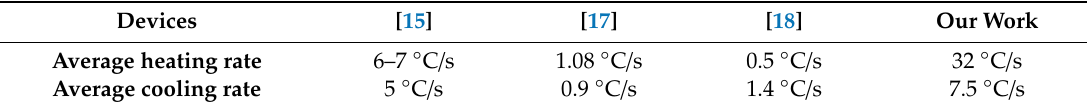
Table 2. Comparison of average heating rate and cooling rate between our work and other portable and battery-powered PCR devices.